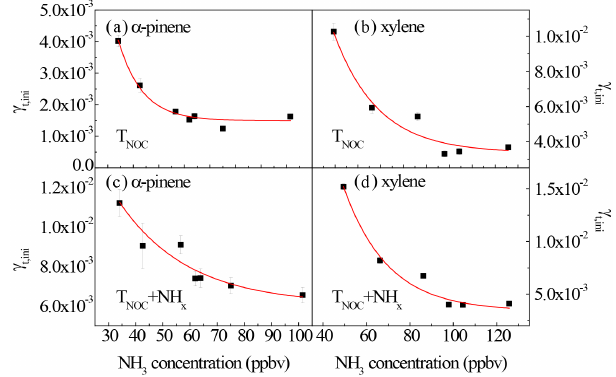
Figure 6. Diffusion corrected uptake coefficient of NH 3 to form NOC species on SOA from O 3 oxidation of α -pinene (a) and OH oxidation of m -xylene (b) , as a function of NH 3 exposure (at fixed H 2 SO 4 / Na 2 SO 4 ratio; 1.95molmol − 1 ). This relationship is also shown for uptake coefficients derived including the NH x fragments (c, d) . The error bars depict 1 σ